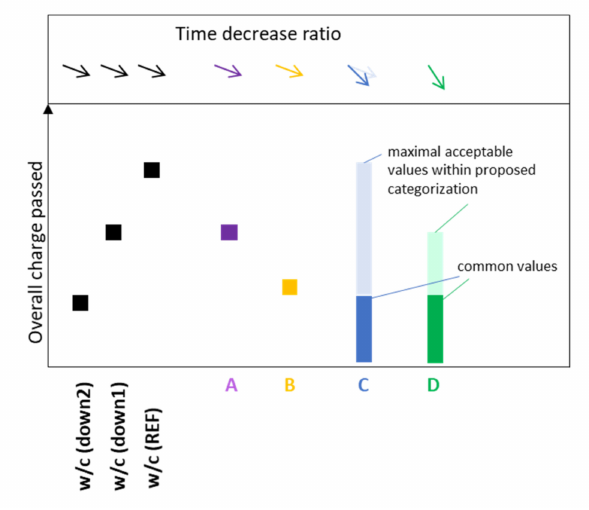
Figure 22. Predicted penetration of ions expressed by charge passing through the CC depending on the type of mineral additive.